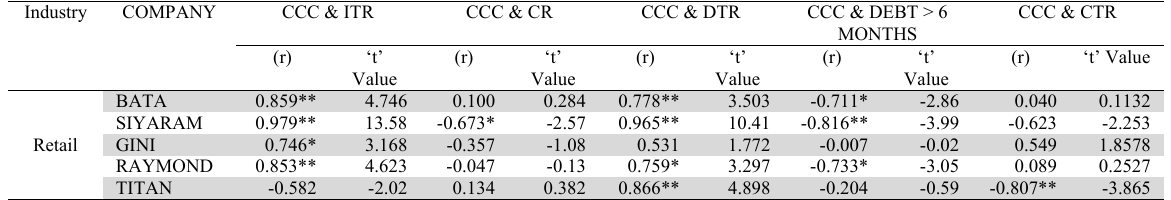
Note: Figures in the parentheses indicate ‘t’